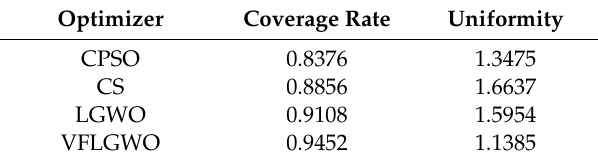
Table 4. Comparison of algorithm coverage and